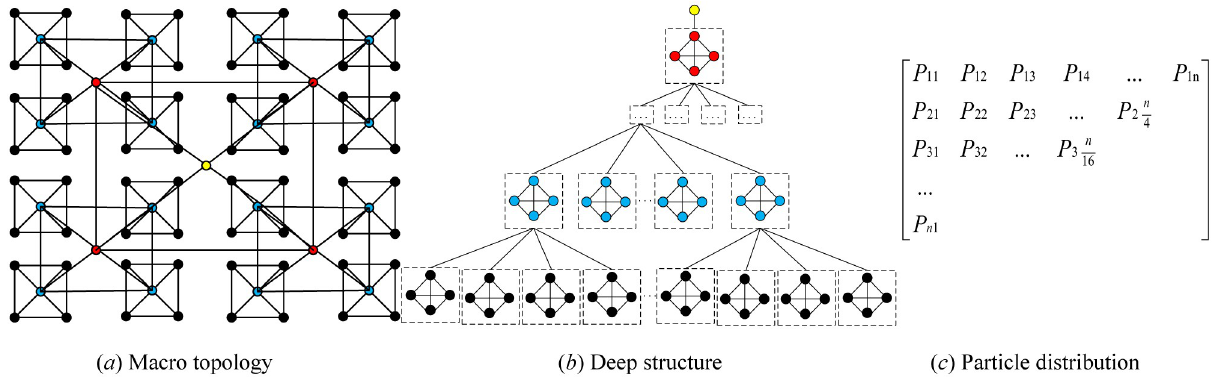
Fig 1. Schematic diagram of local optimal iteration. ( a ) Macro topology. ( b ) Deep structure. ( c ) Particle distribution.